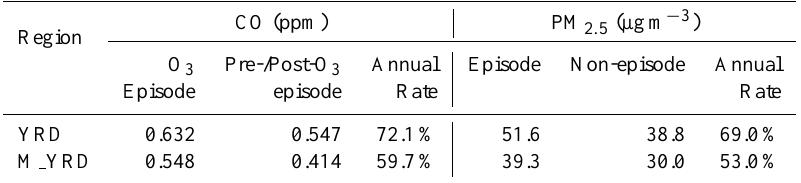
Table 3. Estimation of regional contribution of CO and PM 2 . 5 to the SORPES site during the 1yr